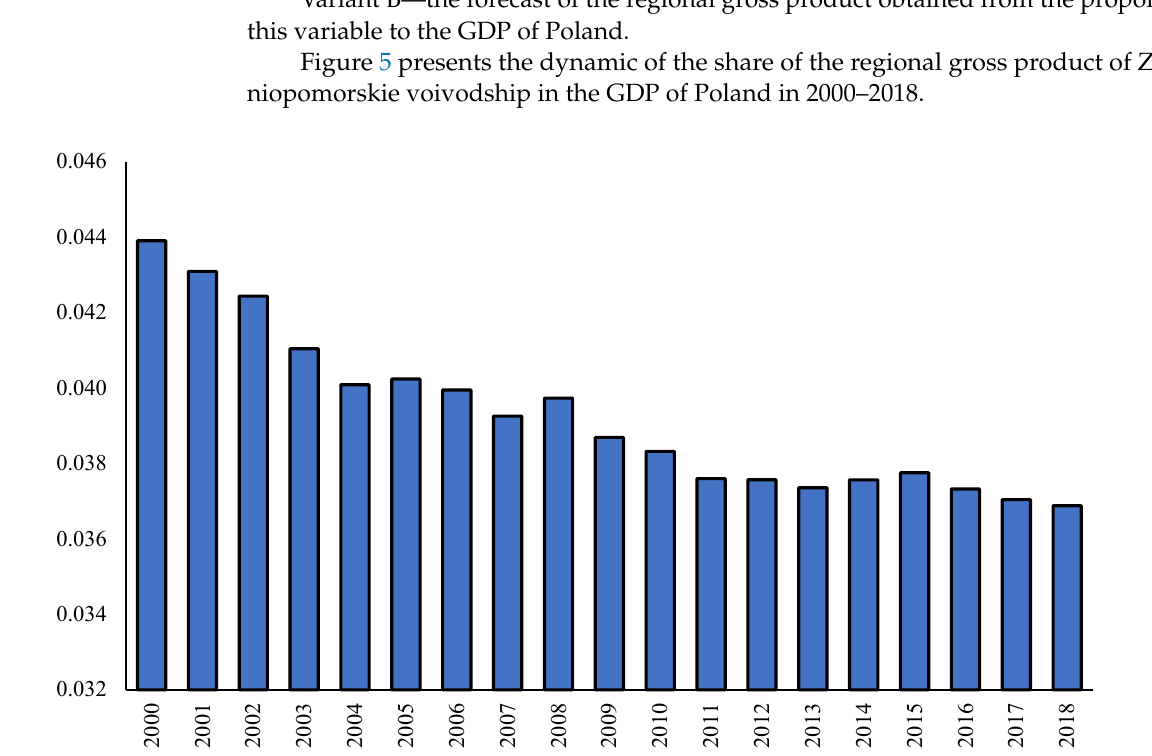
Figure 4. Real values (2000–2018) and forecasts (2016–2018) of revenue of Zachodniopomorskie voivodeship (based on model 9 and forecasts of regional gross product based on model 10).